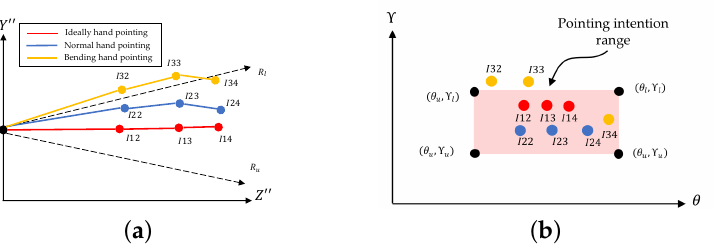
Figure 28. Hand error during pointing mode: ( a ) Index finger over range during pointing mode and ( b ) Error caused from over range during pointing mode.